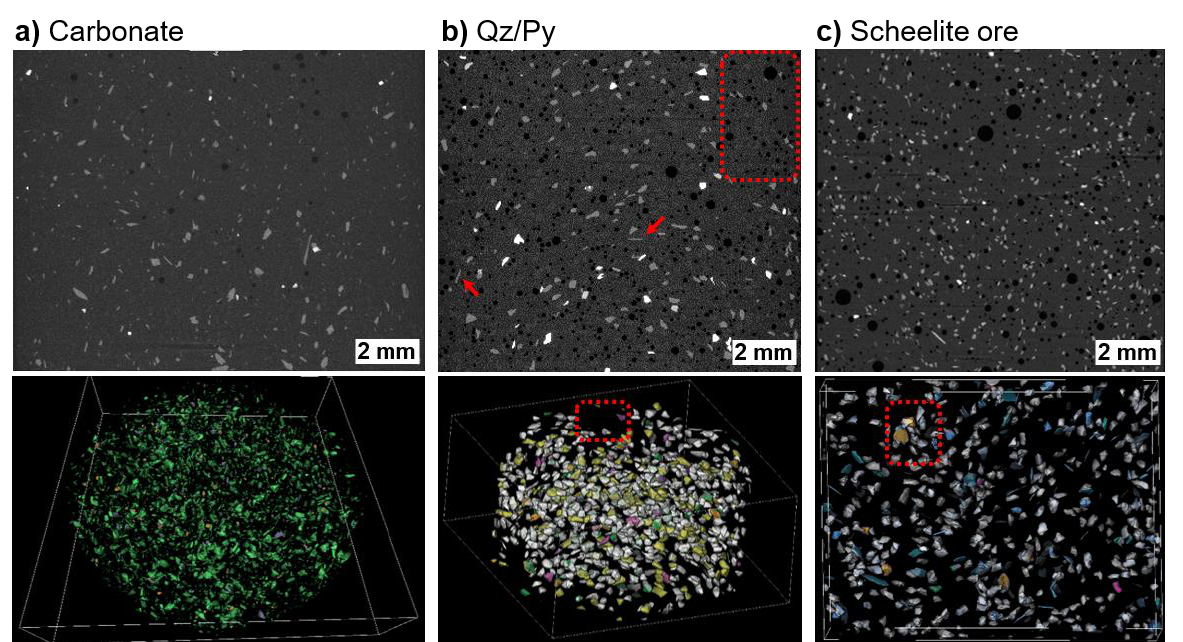
Figure 2. Overview of the CT results for the three samples ( a – c ). On top, are vertical cross-sections of the sample, whereby bubbles are black and particles are grey-tones (brighter colors within each sample correspond to denser phases). On the bottom are 3D views of subvolumes within the sample: ( a ) 14 mm × 14 mm × 3 mm, ( b ) 14 mm × 14 mm × 6 mm, ( c ) 6 mm × 5 mm × 1.1 mm. Colors correspond to mineral groups of minerals with similar grey-values (independent grey-scale for each sample). Table 1. Summary of the types of material used to prepare the three samples analysed. The ParVox is defined as the middle value of the particle size fraction divided by the voxel